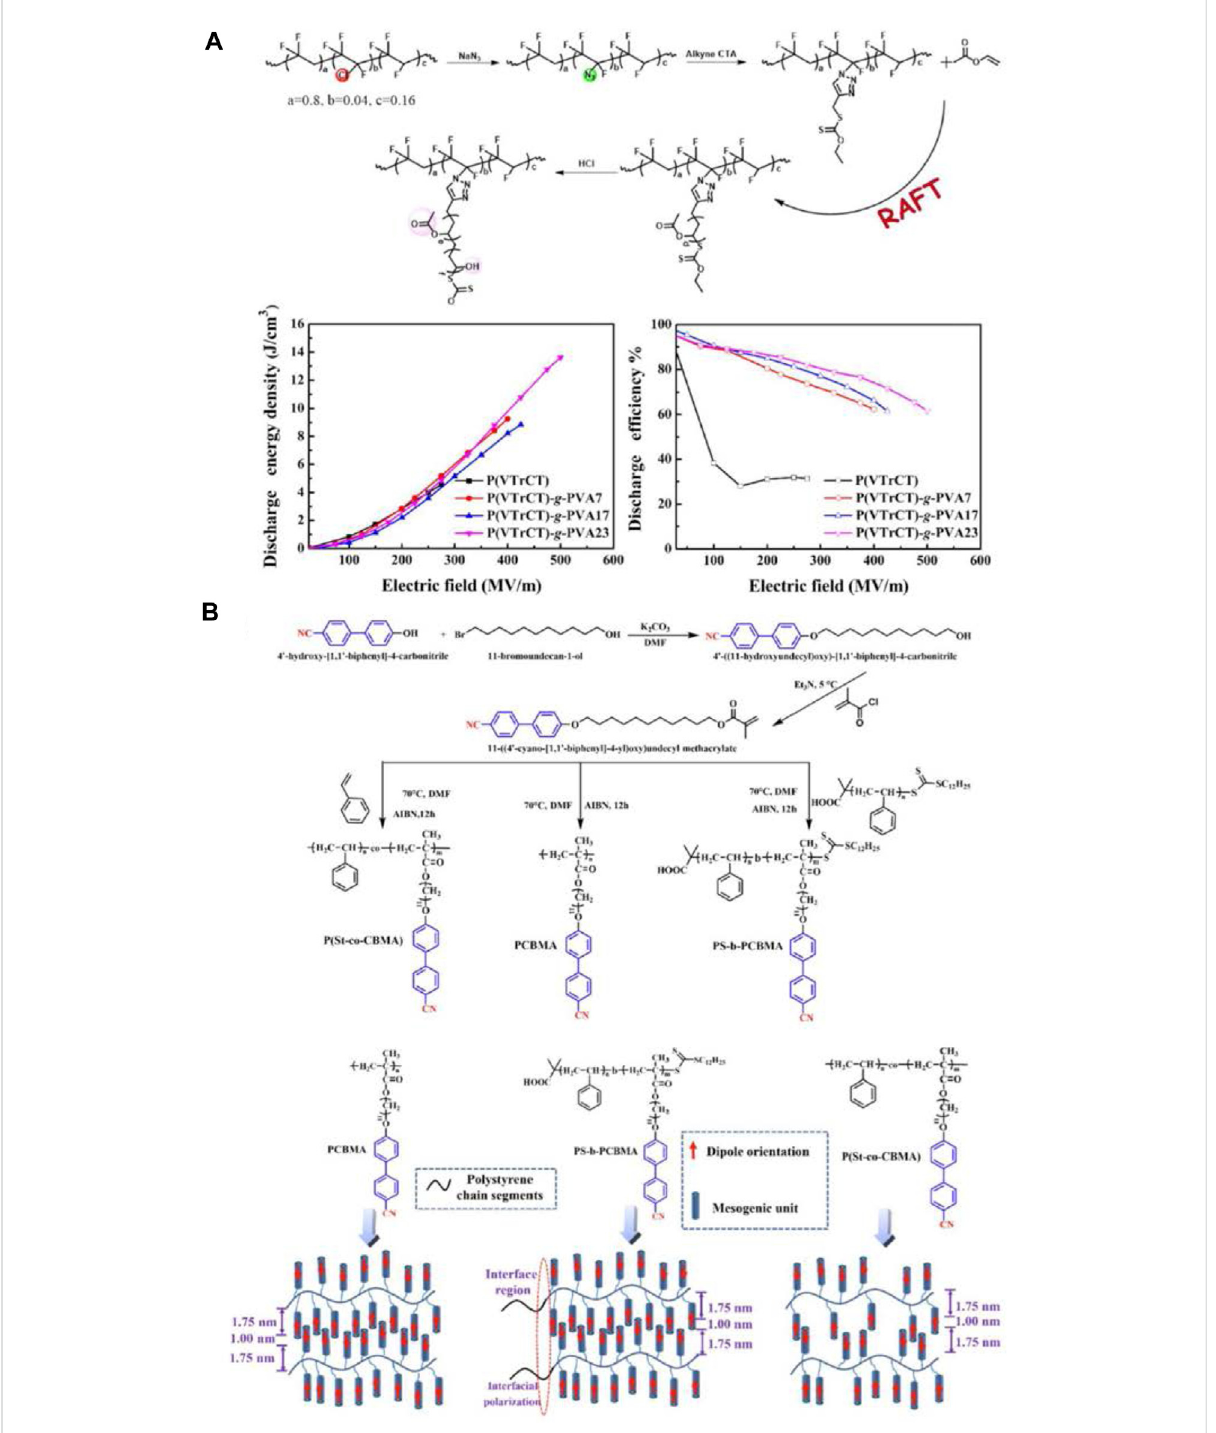
FIGURE 5 (A) Synthesis of P(VTrCT)- g -PVA by RAFT polymerization, and U e and η of P(VTrCT)- g -PVA and pristine P(VTrCT); (B) The preparation routes of monomersandpolymers,anddielectricmechanismofPCBMA,PS- b -PCBMAandP(St- co -CBMA).ReproducedwithpermissionfromRef.72and73. Copyright 2021 and 2022 American Chemical Society and